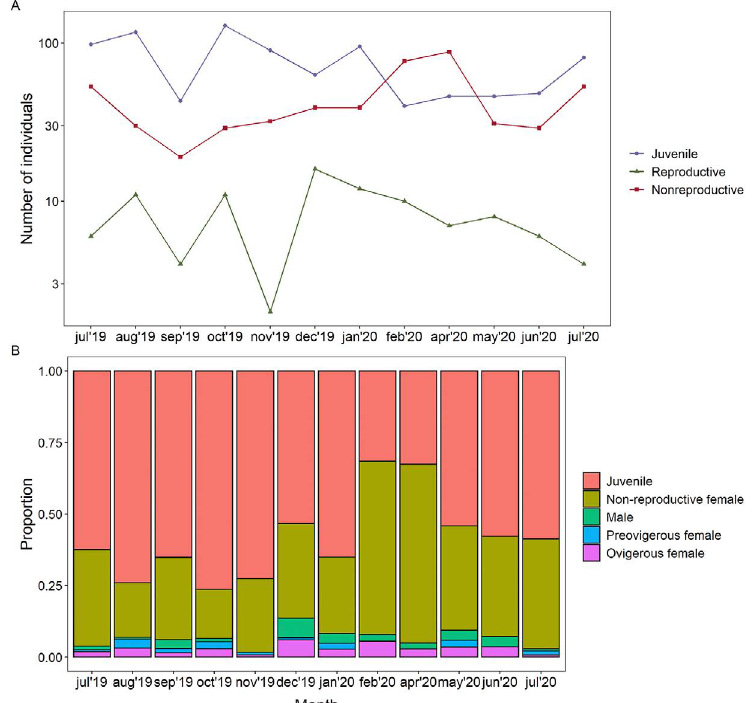
Fig. 4. – A, number of juvenile, non-reproductive and reproductive individuals (males, pre-ovigerous and ovigerous females) per month. B, proportion of different sex categories of Chondrochelia dubia between July 2019 and July